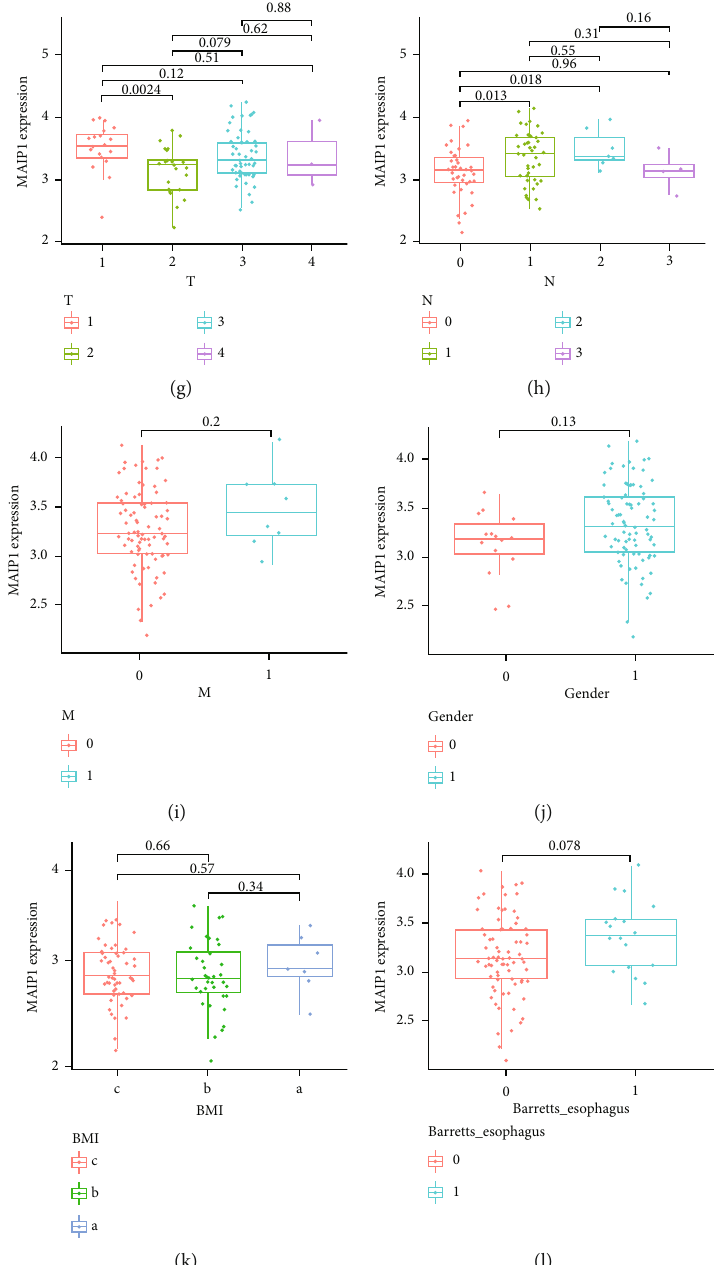
Figure 2: E ff ect of MAIP1 on prognosis and clinical features in EC. (a) Relationship between MAIP1 expression and patient ’ OS. (b – l) Expression of MAIP1 in clinical feature